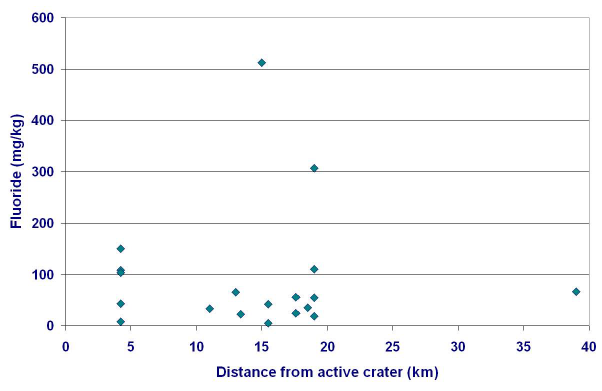
Fig. 5. Fluoride concentrations (mgkg − 1 ) in leachates of the sam- ples listed in Table